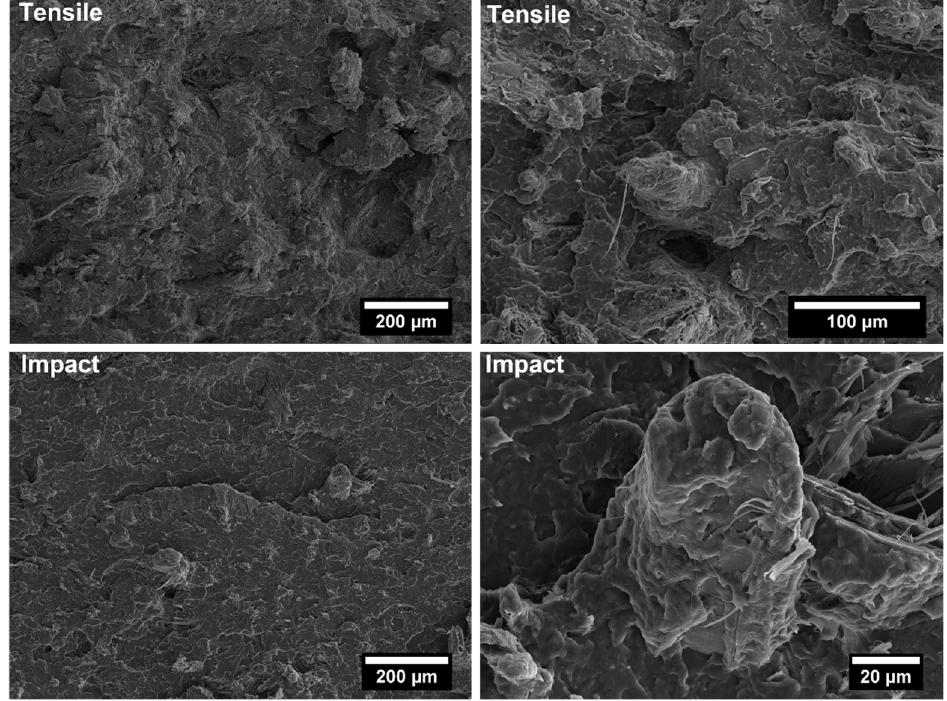
Figure 16. SEM micrographs of PP-based biocomposites with 30 wt.% of willow fillers with coupling agent after tensile and Charpy impact tests.